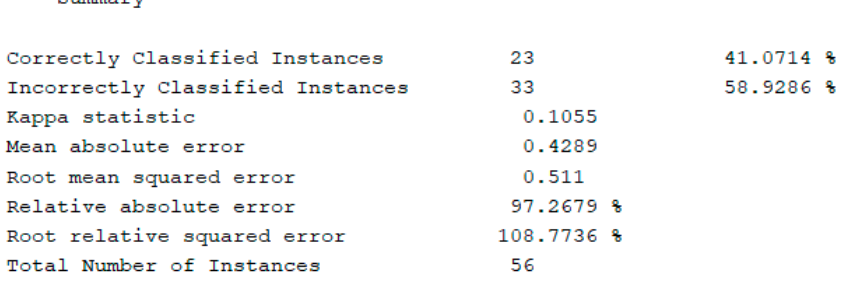
12 of 16 Figure 3. Visualization of analysis results between learning in relation to financial problems. To contrast the algorithm used, the processing was also done with the use of random forest. The data are presented in Figure 4, where it can be seen that it consists of 56 in-